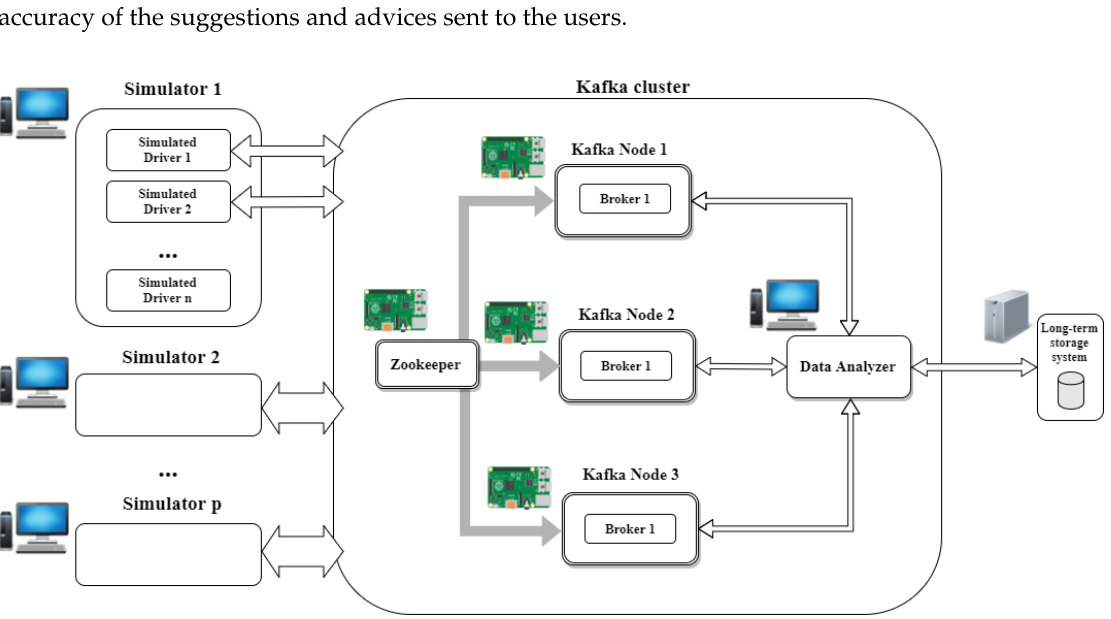
Figure 3. Proposed single-board-computer cloudlet micro data centre architecture. In this architecture, every node is connected to a 24-Port 10 Gigabit Switch, which acts as central node of the star topology employed. Each Kafka cluster node can see the other nodes but the intercommunications are limited to keep the cluster synchronised and Kafka producers and consumers information